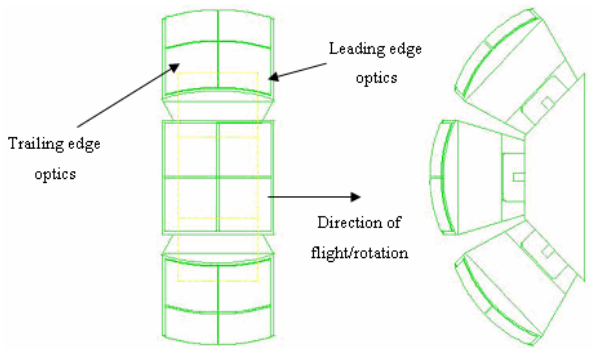
Fig. 10 . Imager configuration for scanning the auroral oval, consisting of a 3 x 1 array of Fig. 10. Imager configuration for scanning the auroral oval, consist- modules, each made up of 4 MCP optic tiles in a 2 x 2 arrangement (as shown in Fig. 2). ing of a 3 × 1 array of modules, each made up of 4 MCP optic tiles in a 2 × 2 arrangement (as shown in Fig. 2).